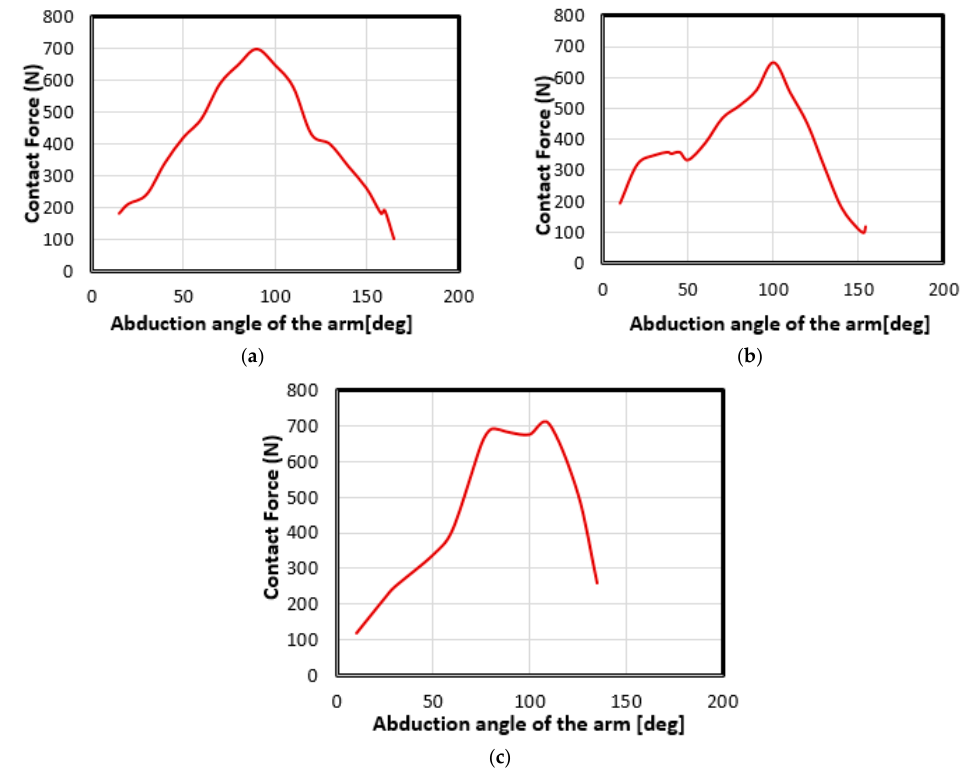
Figure 4. Illustrations of the three models of abduction movement, representing the force applied to the shoulder joint as a function of the abduction angle of the arm in the case of: ( a ) 1st individual, ( b ) 2nd individual and the ( c ) 3rd individual, from [33].